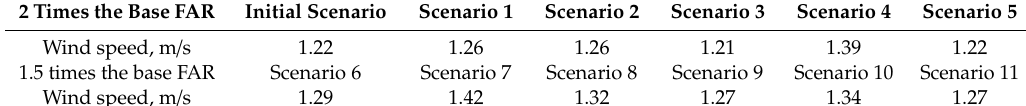
Table 4. Comparison of 24-h-averaged mean wind speed between pairs of scenarios with different FAR values.